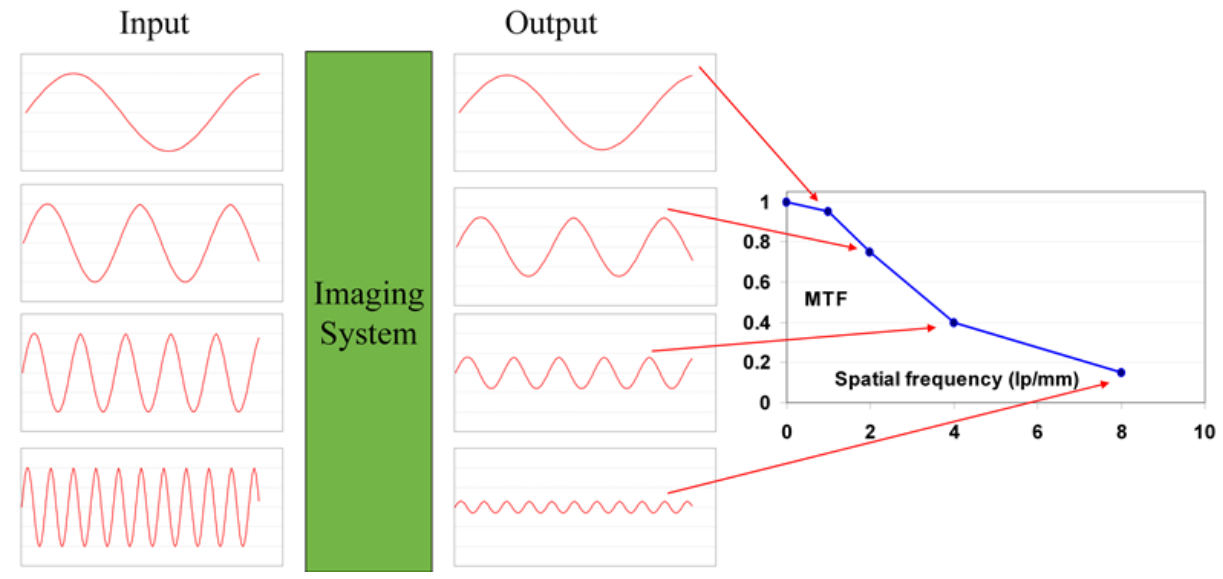
Figure 32. Schematic representation of the MTF